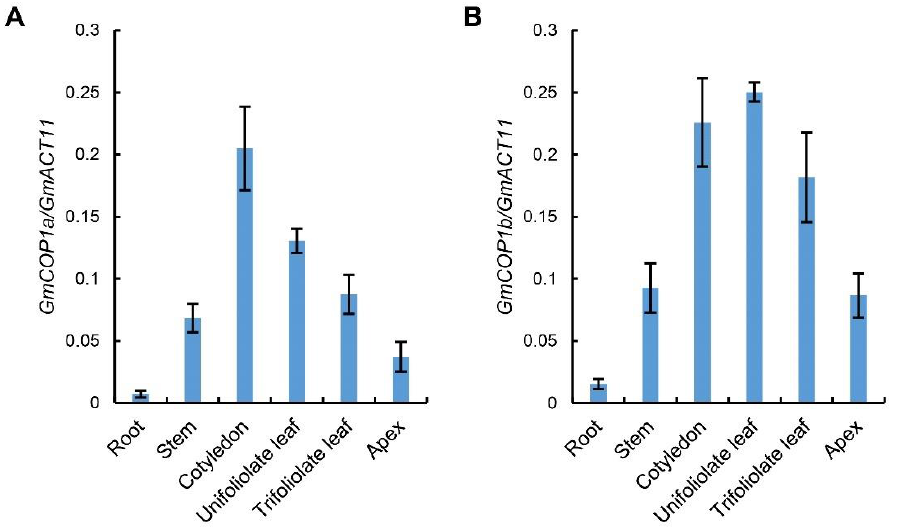
Figure 2. Expression analysis of GmCOP1a and GmCOP1b in different tissues of soybean. ( A , B ) Quantitative PCR (qPCR) results showing the GmCOP1a ( A ) and GmCOP1b ( B ) mRNA levels in the indicated tissues. The values represent the means ± SD ( n = 3). GmACT11 is used as a reference gene.